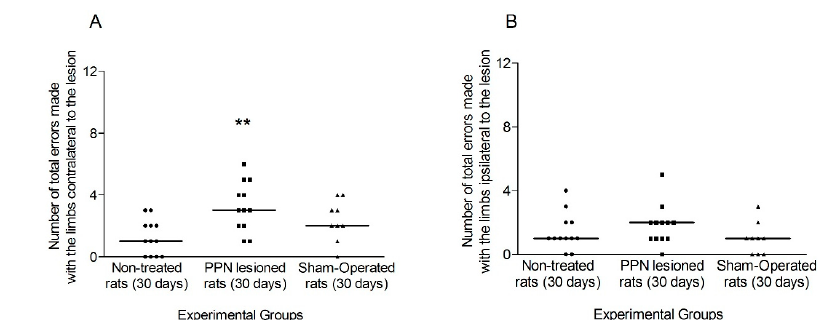
Figure 7. Comparison of the total faults made by the limbs of each side during the execution of Grid Test 30 days after pedunculopontine nucleus lesion. ( A ) Faults made by the contralateral rats’ limbs (H (2,33) = 11.87 p < 0.01). ( B ) Faults corresponding to ipsilateral limbs (H (2,33) = 5.05 p > 0.05). Kruskal– Wallis test. ** p < 0.01. The points represent the number of errors of each experimental subject. The horizontal lines represent the median of each sample.